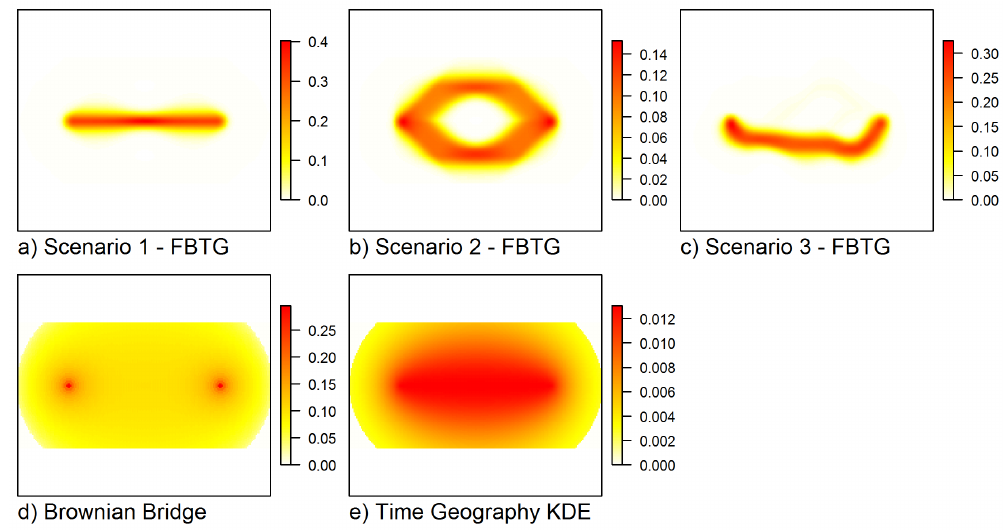
Figure 2: a) - c) Output probability surfaces ( P i ) from the three scenarios using the field- based time geography model, d) the Brownian bridge model, and e) time geographic kernel density